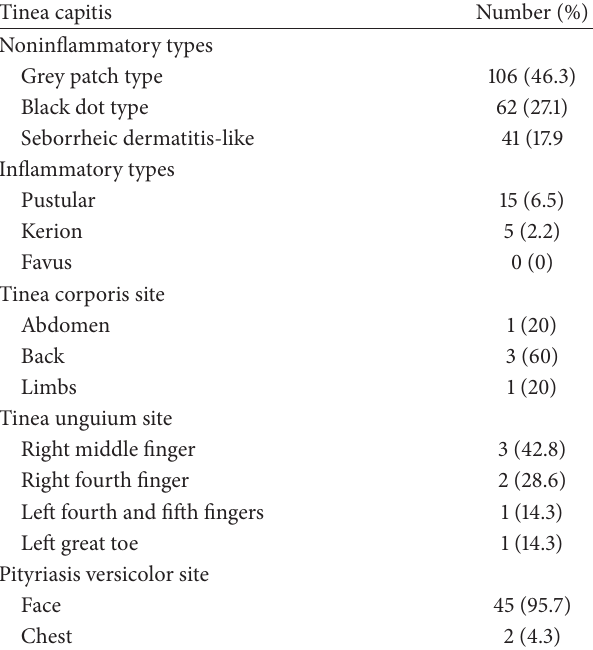
Figure 8: Tinea faciei. Table 3: Clinical Patterns of SFI